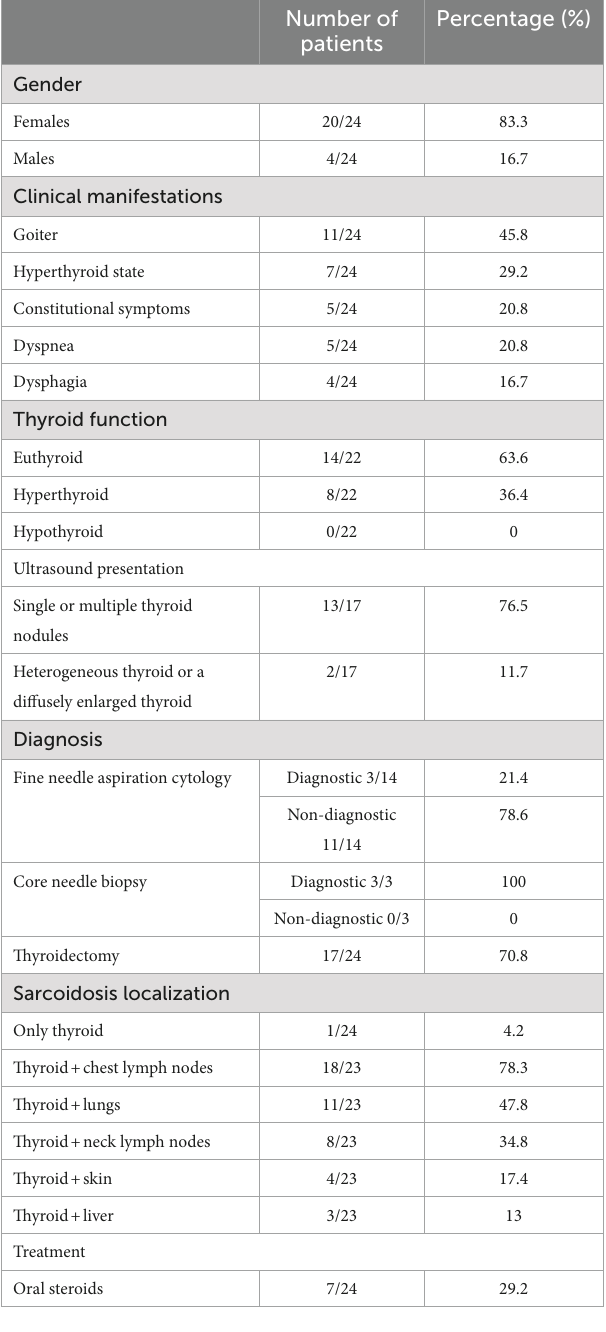
TABLE 2 Literature review of patients with thyroid